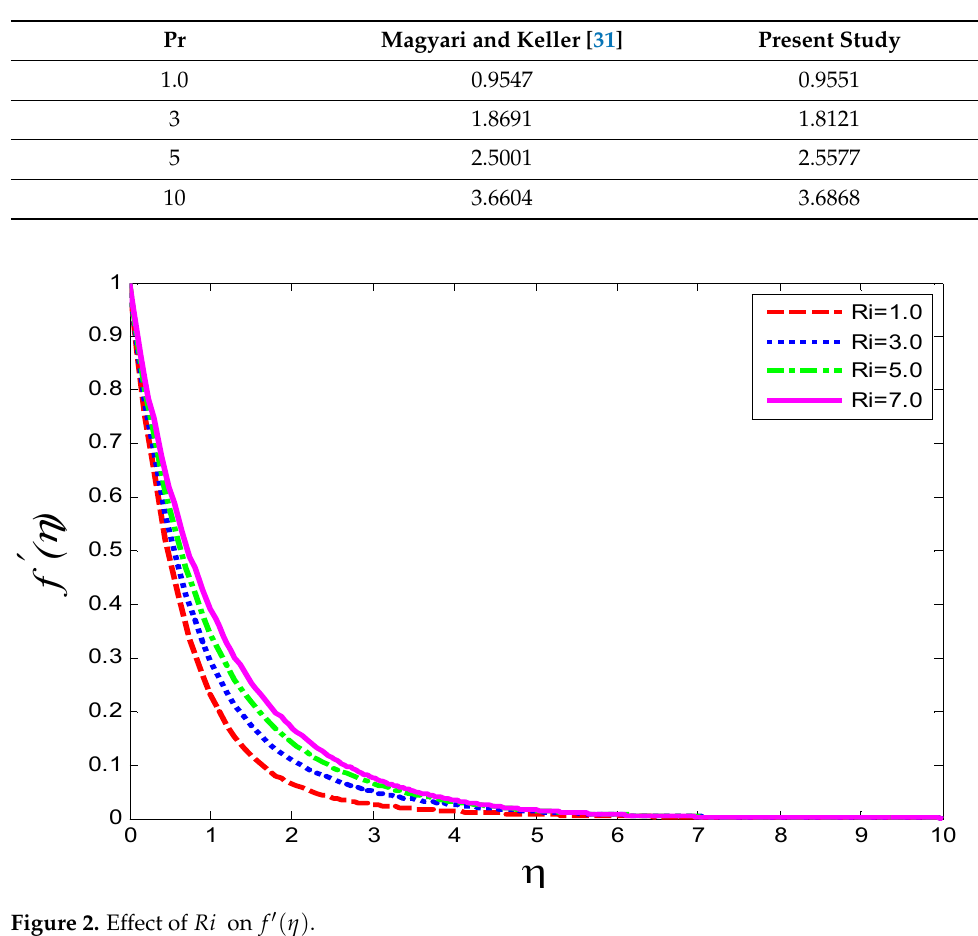
Figure 2. Effect of Ri on f (cid:48) ( η )